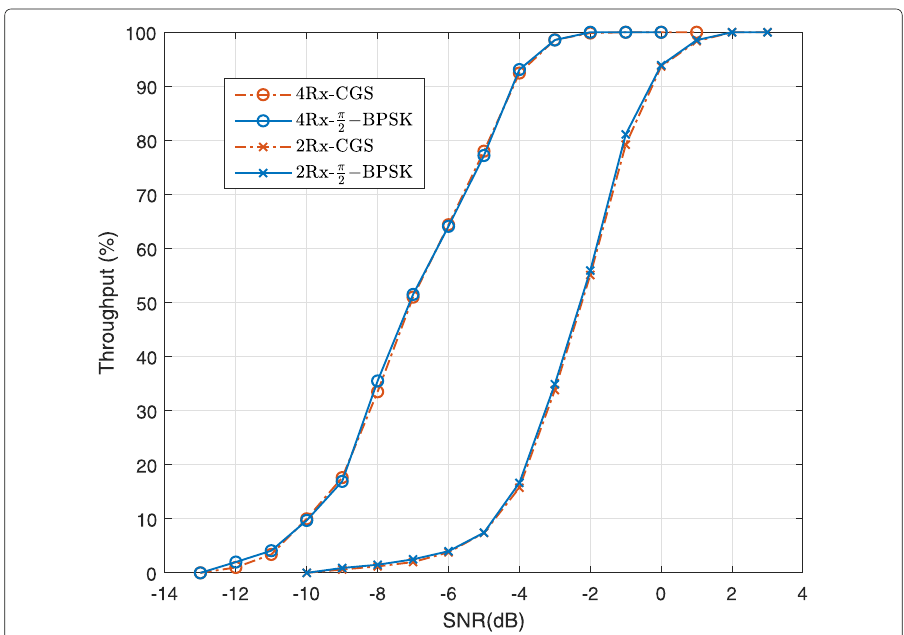
Fig. 20 Throughput comparison for the length-24 DMRS sequences In Figs. 21 and 23, we show the PAPR and BLER performance for the two MIMO streams transmission setting where DMRS is transmitted on both port 0 and port 1 using our proposed method 1 transceiver design. It can be seen that both PAPR, as well as BLER, are identical for both ports confirming that the proposed transmitter design produces identical DMRS sequences on both ports.